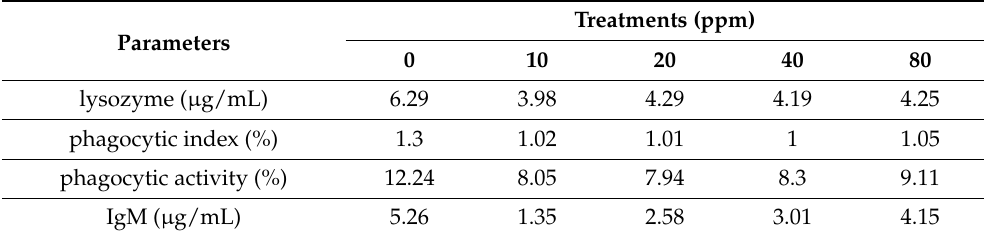
Table 8. Immune responses of the Nile tilapia , O. niloticus exposed to different concentrations of biosynthesized Hi -ZnO-NPs.